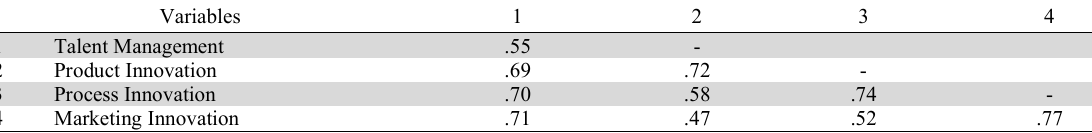
Fornel-Larcker Criterion